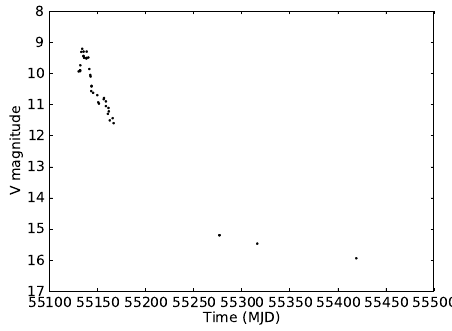
Figure 1: V band photometry of V5584